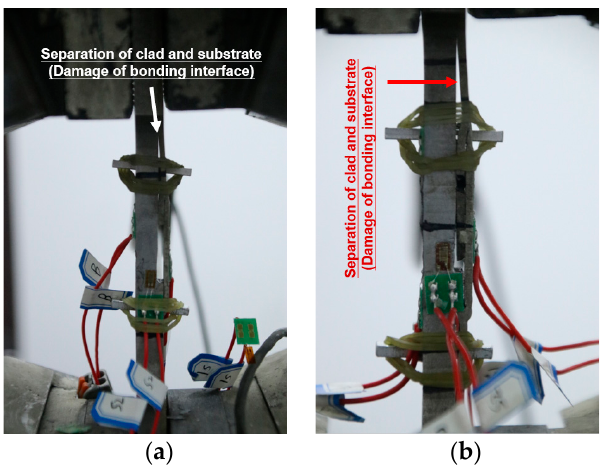
Figure 10. Local separation of clad and substrate layers. ( a ) Type III welded joint without filler plate and ( b ) Type III welded joint with filler plate.